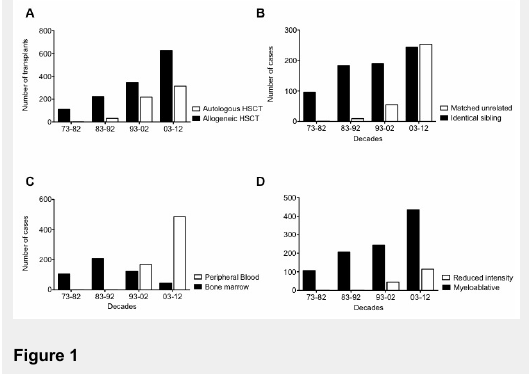
(A) Total allogeneic and autologous haematopoietic stem cell transplantation (HSCT) numbers over the decades. (B) Identical sibling and matched unrelated allogeneic HSCT patient case numbers over the decades. (C) Bone marrow and peripheral blood stem cell source patient case numbers in allogeneic HSCT. (D) Patient case numbers receiving myeloablative and reduced- intensity conditioning for allogeneic HSCT.